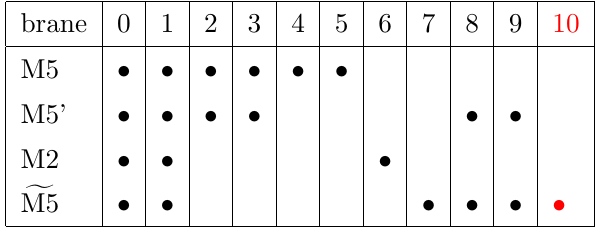
Figure 2 . Mass deformations: (a) Complex mass (b) Twisted mass.